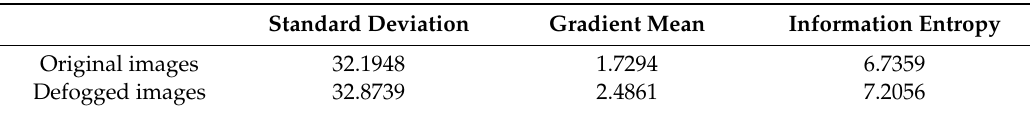
Table 1. Evaluation of defogging algorithm: average standard deviation, gradient mean and information entropy values on four analyzed video datasets.